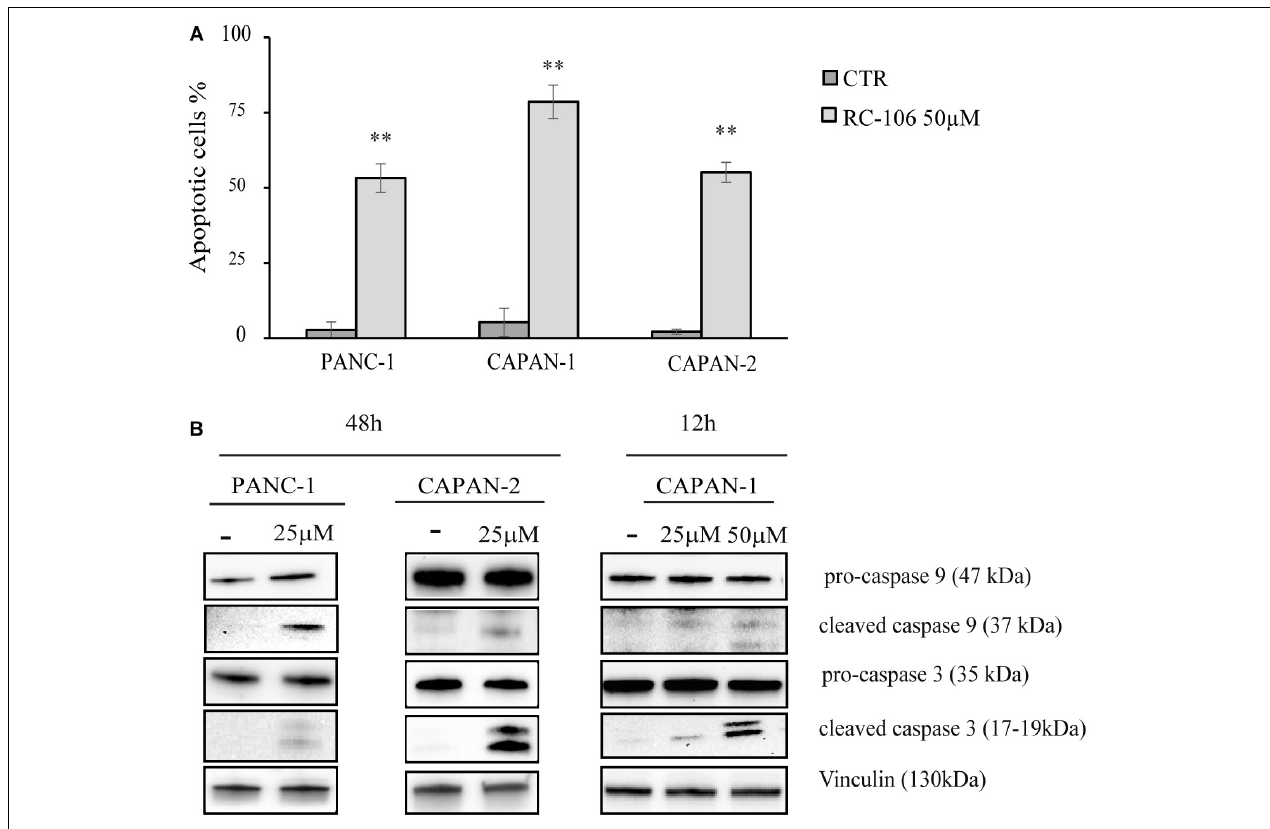
FIGURE 3 | Apoptosis analysis. (A) TUNEL assay performed on Panc-1, Capan-1, and Capan-2 cell lines. Cells were treated with RC-106 50 µ M for 48 h. Values are the mean ± SD of three independent experiments. ∗∗ P < 0.01 vs. CTR. (B) Western Blot analysis of caspase 3 and 9 activation after 48 h treatment with RC-106 25 µ M (Panc-1 and Capan-2) and after 12 h treatment with RC-106 50 µ M (Capan-1). Images are representative of two independent experiments.